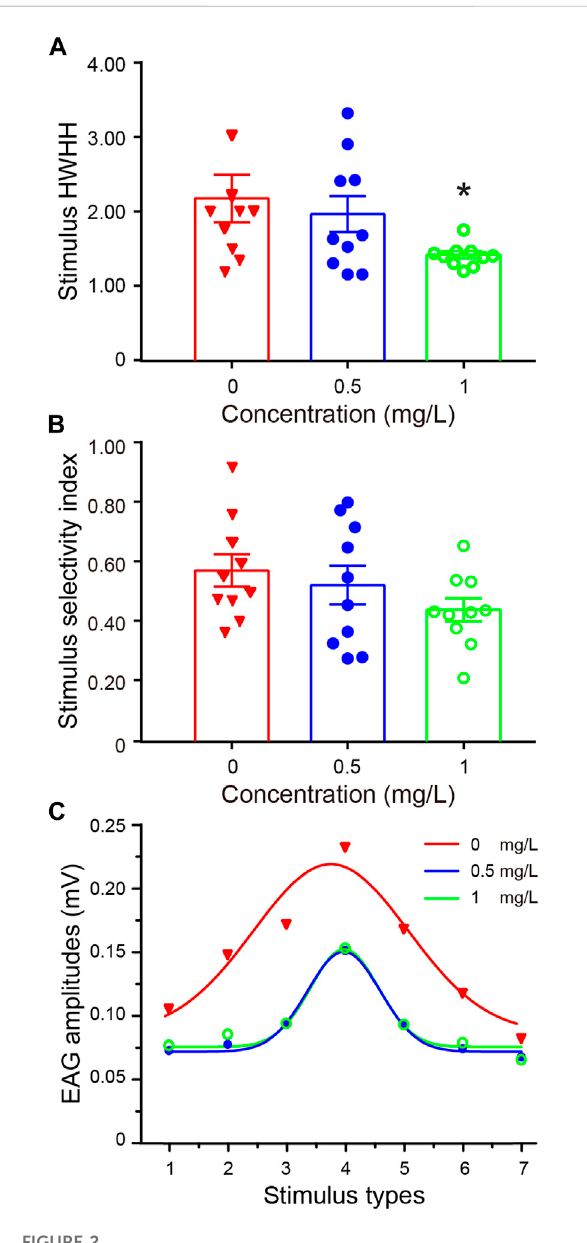
FIGURE 2 Distributionsofolfactoryselectivityforeachtreatmentgroup. (A) Mean olfactory tuning width (half-width at half-height of the waves, HWHH) distributions. The HWHH in the 1.0 mg/L thiacloprid treatment group is signi fi cantly lower than that of the control group (Kruskal – Wallis followed by Dunn ’ s test, p = 0.042). The error bars are SEM, N = 10 bees in each treatment group, with three technical replicates. (B) Average olfactory selectivity index (SI) across all treatment groups (mean ± SEM). The treatment groups showed no signi fi cant differences (one-way ANOVA followed by Dunnett ’ s test, 0.5 mg/L vs . 0 mg/L, p = 0.747; 1.0 mg/L vs . 0 mg/L, p = 0.165). (C) Gaussian- fi tcurvesofallantennaeresponsestosevenodorresponses in three treatment concentrations (0 mg/L, 0.5 mg/L, and 1